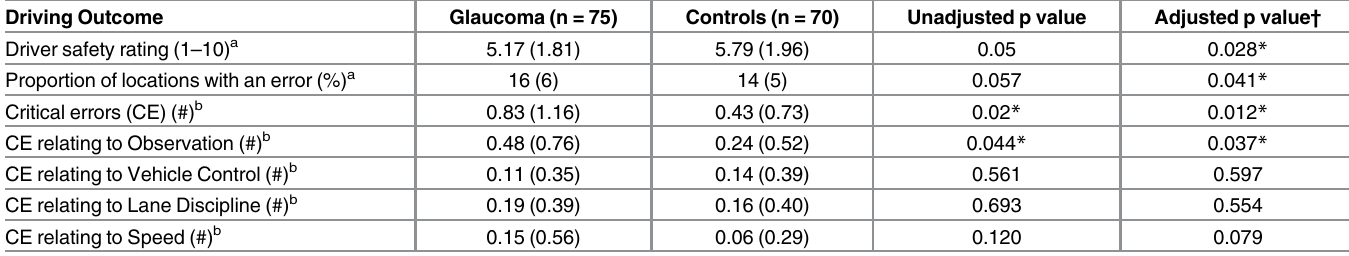
Table 3. Summary scores for on-road driving assessment as a function of group status (mean ± SD) with unadjusted and adjusted p values.